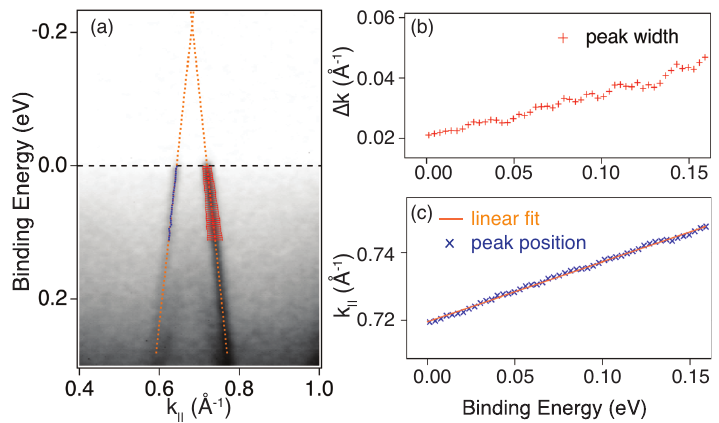
Figure 4: Self energy analysis of the Y-states (a) I(E,k || ) along Γ − Y measured with 88 eV photons. The data are overlaid with blue dots (MDC peak position from Lorentzian fit) and red bars (fitted MDC width) and the orange dotted line shows the fitted dispersion relation. (b): MDC peak widths ∆ k . (c) A linear fit to the dispersion matches well with the fitted MDC peak